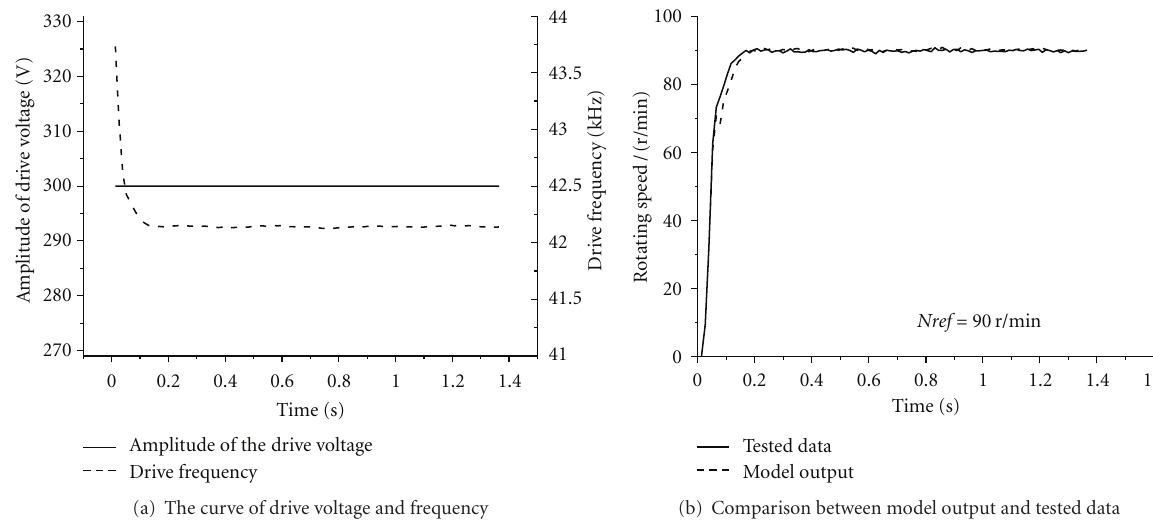
(b) Comparison between model output and tested data Figure 14: Step response comparison between model output and tested data ( Nre f = 90r/min, Ure f = 300V, load torque = 0.2Nm).